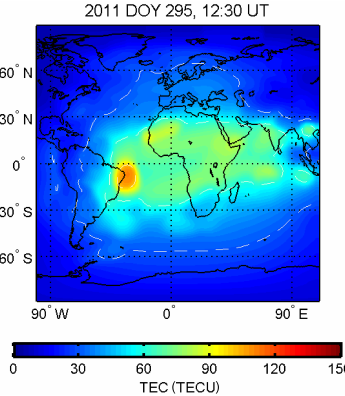
Figure 8. IRS calculated from the reconstructed three-dimensional electron density.